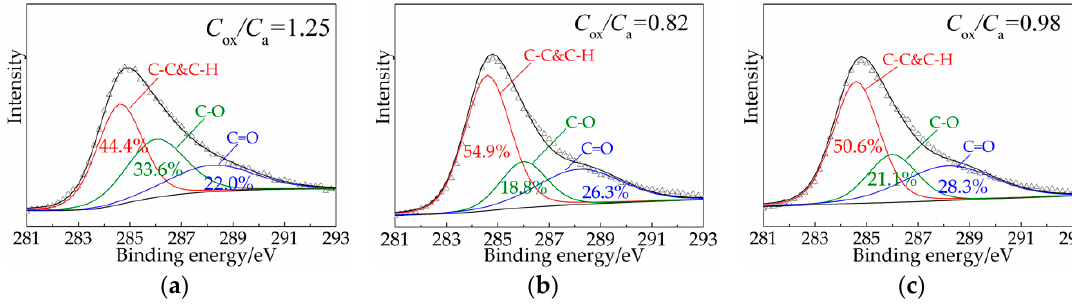
Figure 10. C 1s XPS spectra of the residues after cone calorimeter tests: ( a ) BA, ( b ) AL2, and ( c ) AL25.